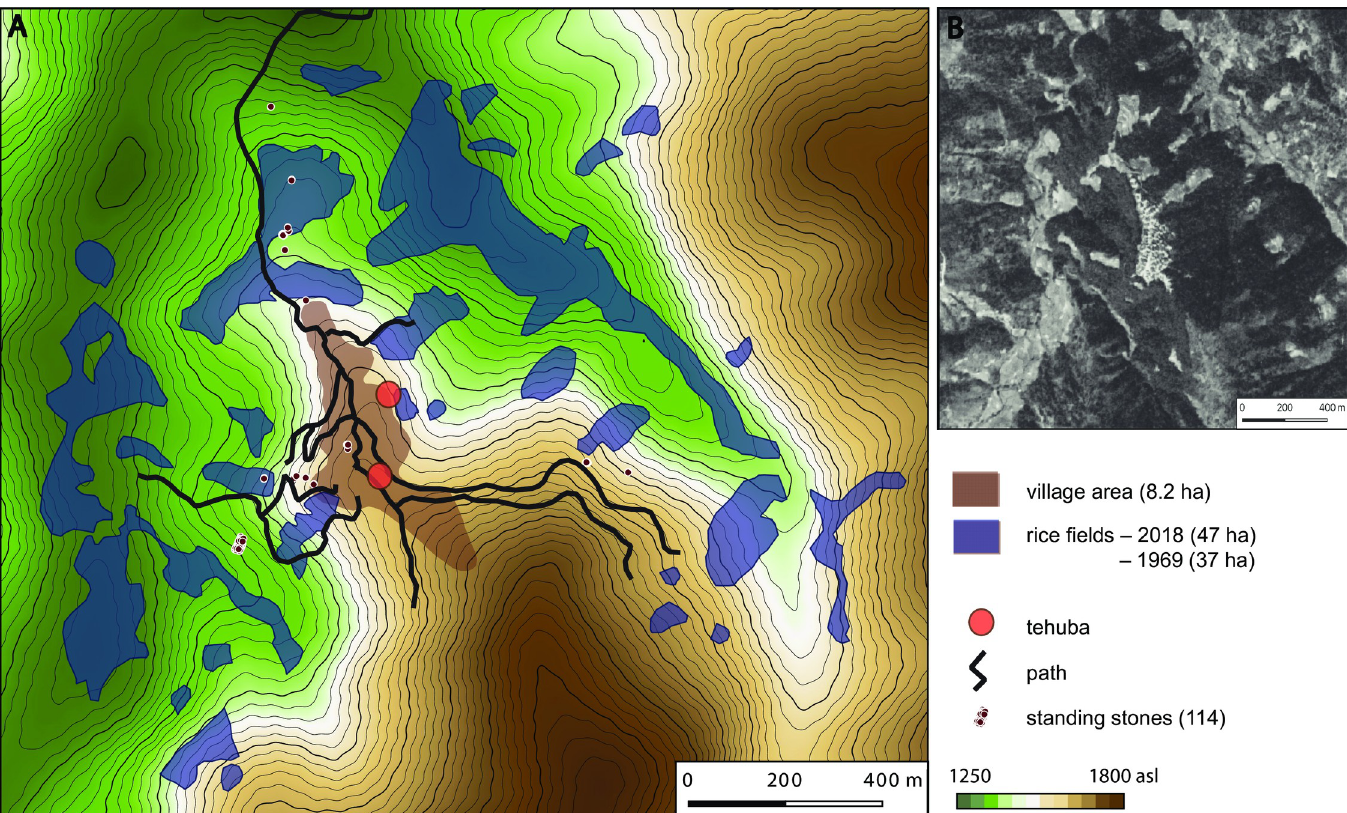
Fig 5. The Chakhesang Naga village of Ru¨nguzu and its surrounding landscape. A: data collected during the field season in 2016. The distribution of the standing stones marks the paths leading towards the terraced fields. B: satellite image of the village (Graphic: RGK Frankfurt; B based on CORONA Satellite Photography, (USGS) EROS Center (EDC); DEM based on CGIAR-CSI SRTM data. DEM republished from Jarvis A., H.I. Reuter, A. Nelson, E. Guevara, 2008, Hole-filled seamless SRTM data V4, International Centre for Tropical Agriculture (CIAT), available from http://srtm.csi.cgiar.org, under a CC BY license, with permission from Alliance of Bioversity International and CIAT, original copyright